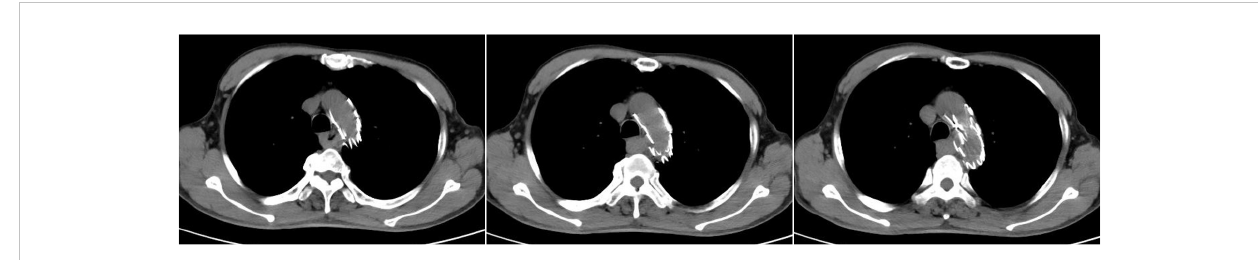
FIGURE 1 Chest CT scan on December 26, 2020, showing postoperative stent changes in the aortic arch and descending aorta and local thickening of the middle esophagus. (Because the patient showed allergy to contrast agents in the past, enhanced CT was not